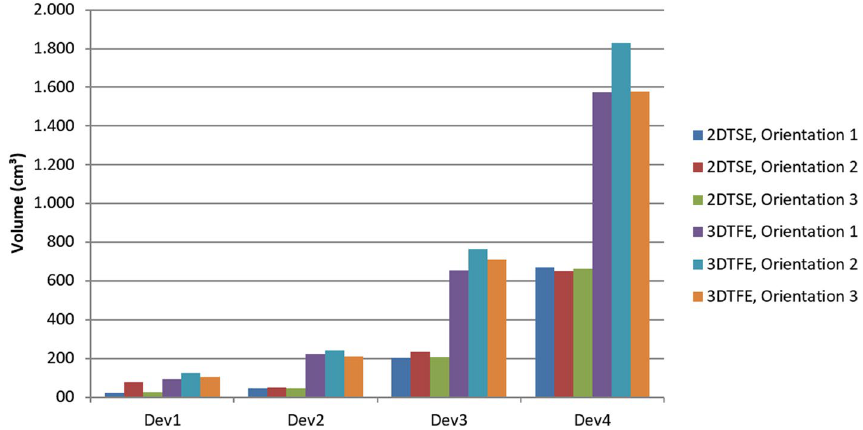
Figure 5. Comparison of signal void volumes depending on the scan sequence and the device (phantom) orientation. Dev1: cardiac loop recorder, Dev2: pacemaker, Dev3 and Dev4: ICDs.